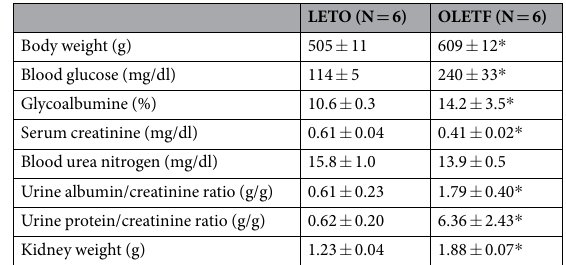
Table 1. Baseline parameters in LETO and OLETF. Values are means ± SEM. * p < 0.05 vs.